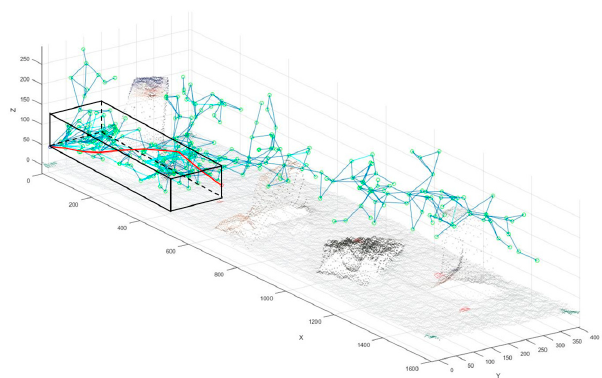
Figure 9. The edges of the tree are presented in blue. The feasible path is shown in red. The cube in black shows the limited space, for the random sample, generated on the RRT* Limits.